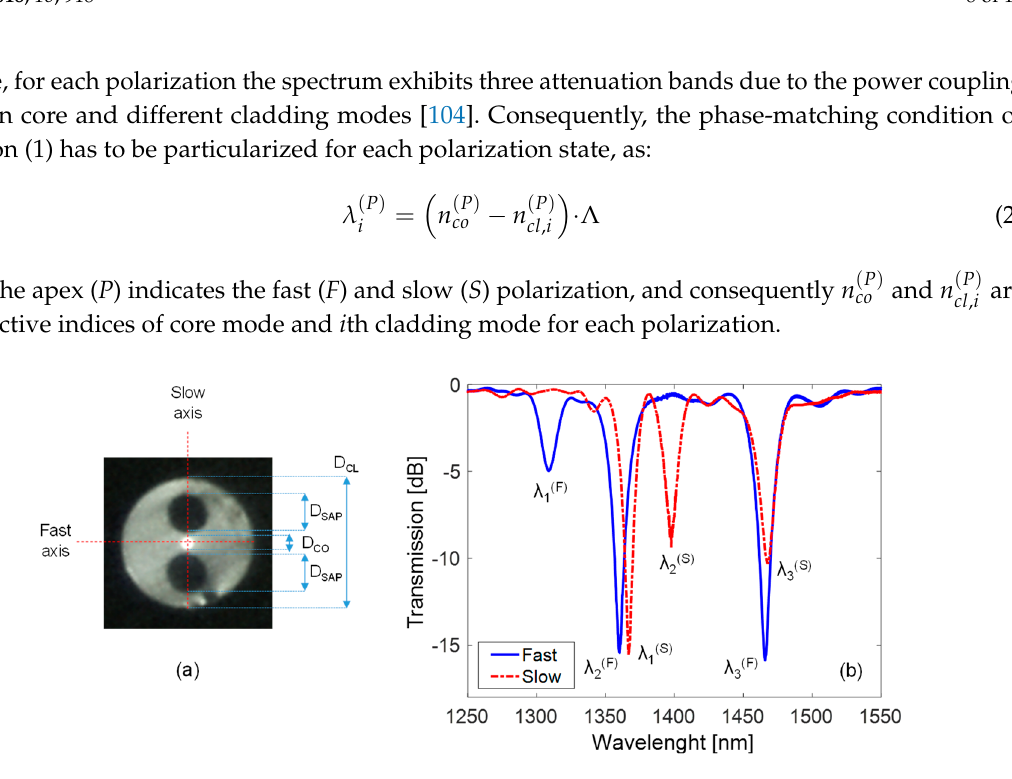
7 of 19 Figure 4. ( a ) Transmission spectra of LPGs in SMF28, with period Λ in range 350–500 µm; ( b ) Phase- matching curves, comparison between numerical (solid lines) and experimental values (diamond for (cid:2019) (cid:2870) , triangle for (cid:2019) (cid:2871) , circle for (cid:2019) (cid:2872) , pentagram for (cid:2019) (cid:2873) , square for (cid:2019) (cid:2874) ). In order to support the fabrication phase and to validate the experimental results, a numerical model based on the coupled-mode theory (CMT) was developed [15]. This model allows determining the spectrum of a LPG, given the properties of the hosting fiber and grating, e.g., fiber geometry, core and cladding RI, external medium RI, grating modulation strength, period, and length [21]. In particular, we